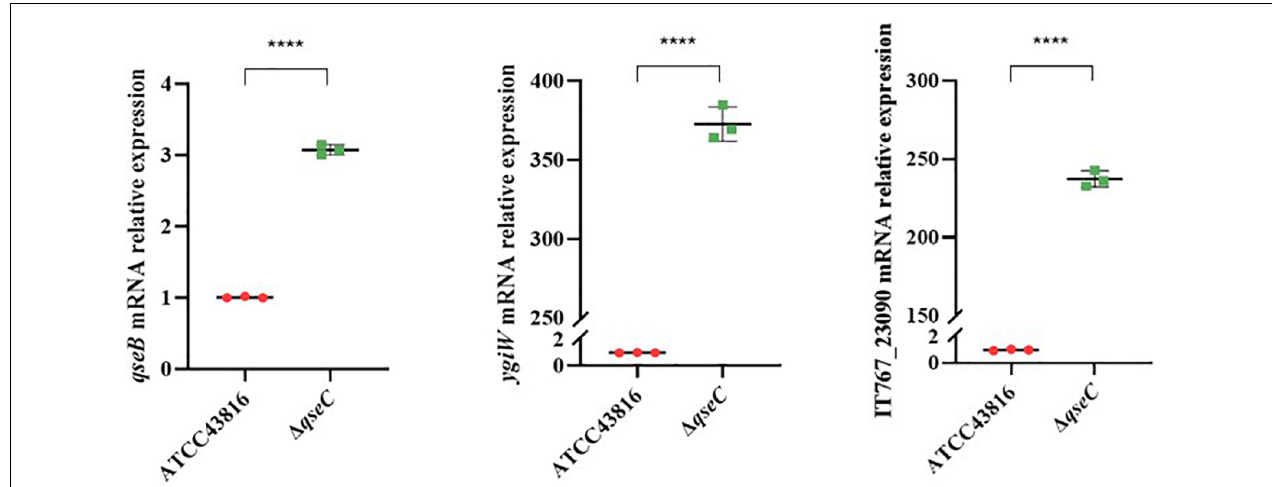
FIGURE 7 | (A) Expression of genes qseB , ygiW , IT767_23090 in ATCC43816 and (cid:49) qseC . Cultures of ATCC43816 and (cid:49) qseC were grown in LB medium to late-exponential phase, and expressions of genes qseB , ygiW , IT767_23090 were measured by qRT-PCR and normalized to the expression in the wild-type strain. Data were mean ± standard deviation of three replicates. Significant expression differences between the wild-type and qseC mutant were determined using t test. **** P < 0.0001. (B) Expression of genes qseB , ygiW , IT767_23090 in ATCC43816-pBAD24, (cid:49) qseC -pBAD24 and the complement strain (cid:49) qseC -pC qseC . Data were mean ± standard deviation of three replicates. Significant expression differences between the wild-type and qseC mutant were determined using t test. * P < 0.05, *** P < 0.001, **** P < 0.0001.